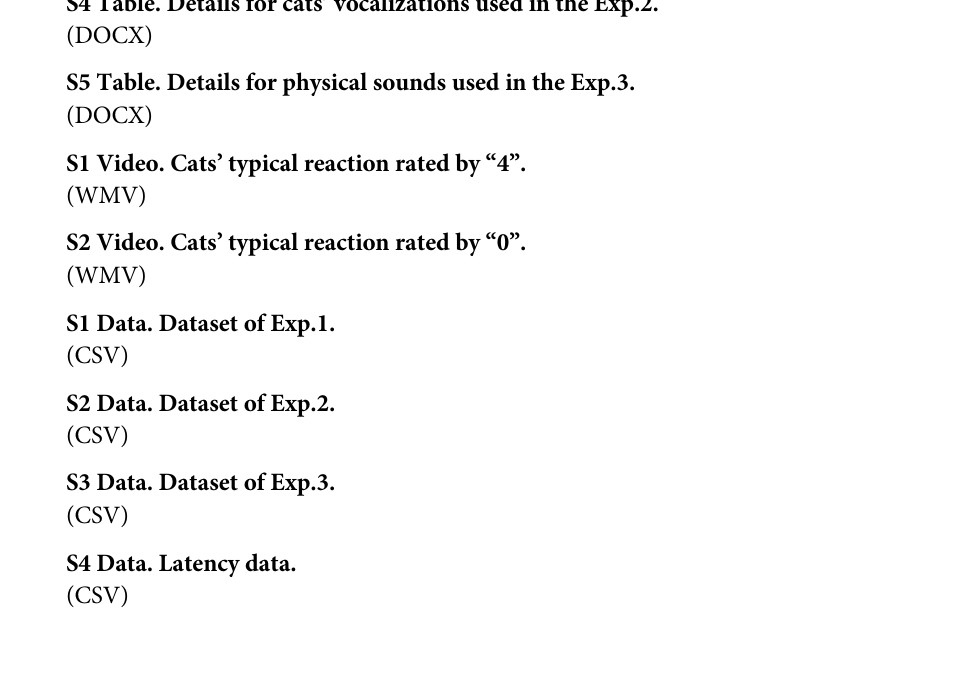
S1 Table. Subject information in Exp.1. Subjects’ age, sex, living, whether they join the other experiment, error type of trial if a trial was excluded in Exp.1. S2 Table. Subject information in Exp.2. Subjects’ age, sex, which cat cafe´, whether they join the other experiment, error type of trial if a trial was excluded in Exp.2. S3 Table. Subject information in Exp.3. Subjects’ age, sex, living, whether they join the other experiment, error type of trial if a trial was excluded in Exp.3. S4 Table. Details for cats’ vocalizations used in the Exp.2. S5 Table. Details for physical sounds used in the